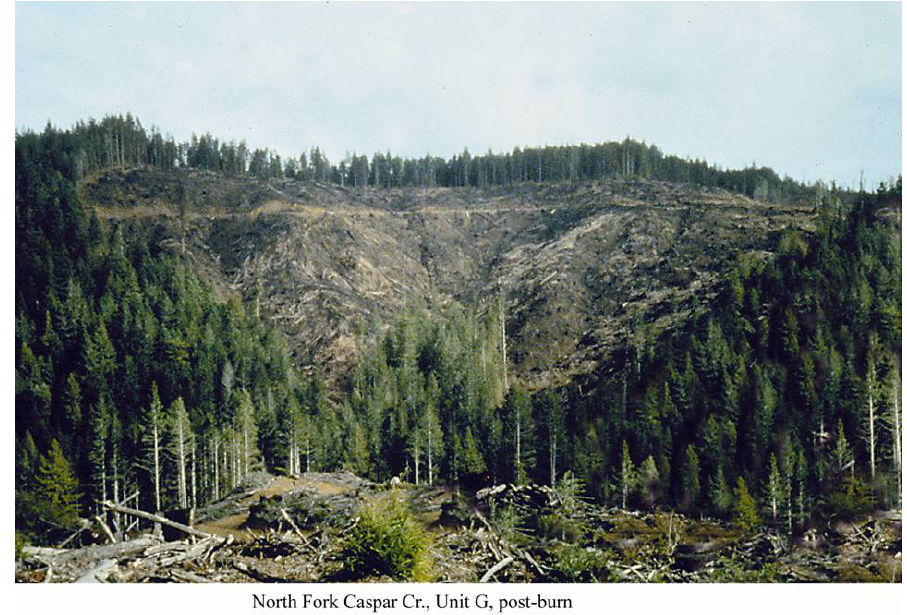
Figure 3. Typical timber harvest under current state rules. North Fork Caspar Creek, Jackson State Forest, Mendocino County, northwestern California. See Figure 4 for details of down slope effects from this exposure of the headwaters of the stream network. Photo by Tom Lisle.